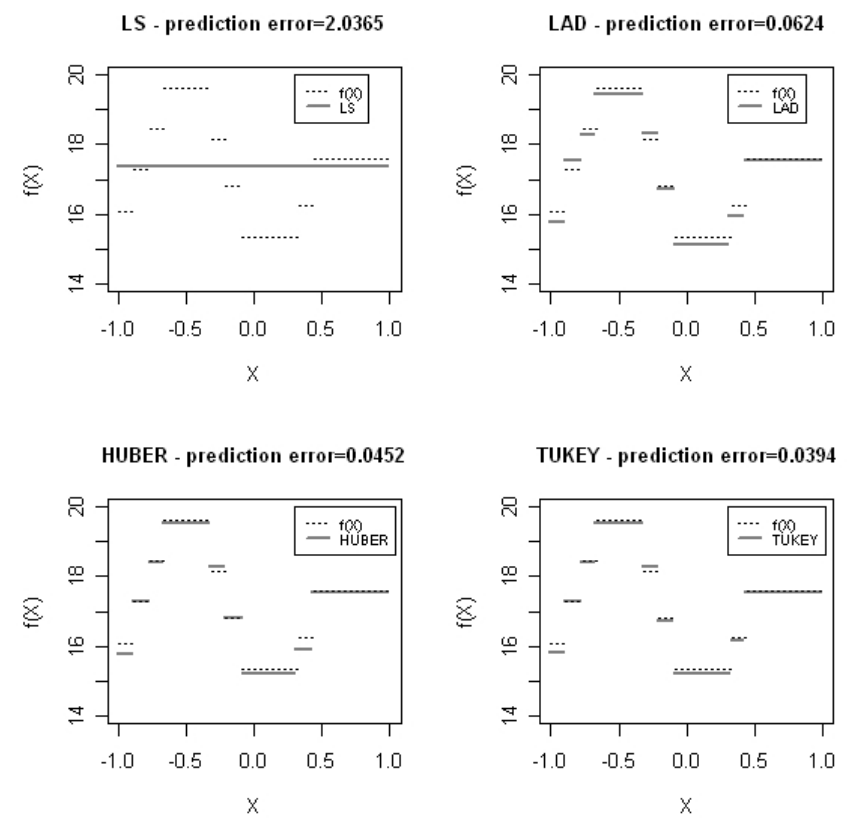
Figure 8 – Regression trees obtained from the analysis of the sample illustrated in Figure 7 through four different split